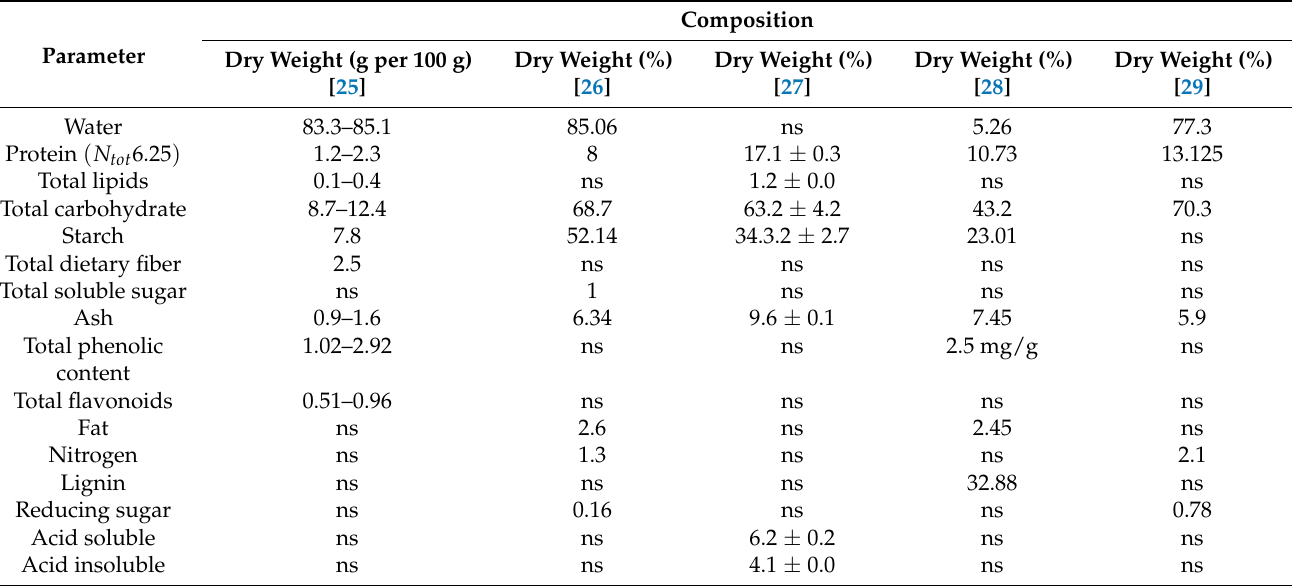
Table 1. Chemical composition of raw potato peel